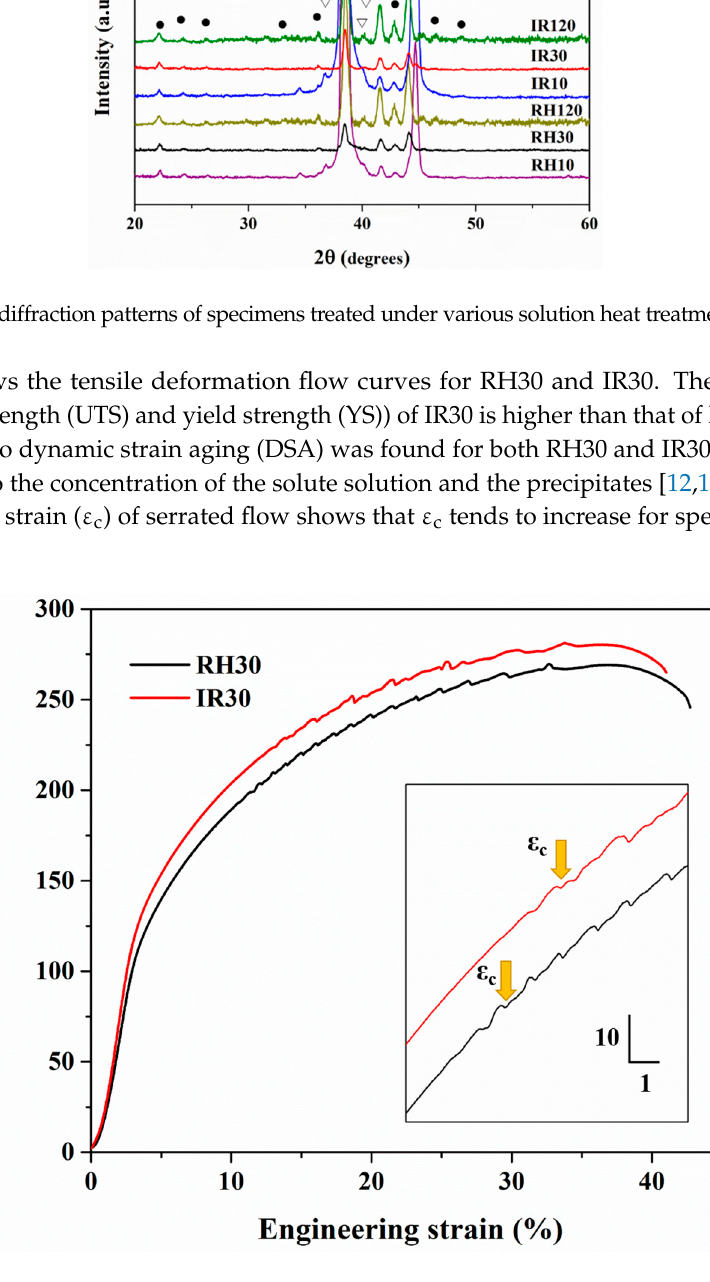
Figure 9. Effect of heating rate before solutionization on critical onset strain ( ε c ) of tensile serrated flow curve of 6082 forging specimens.